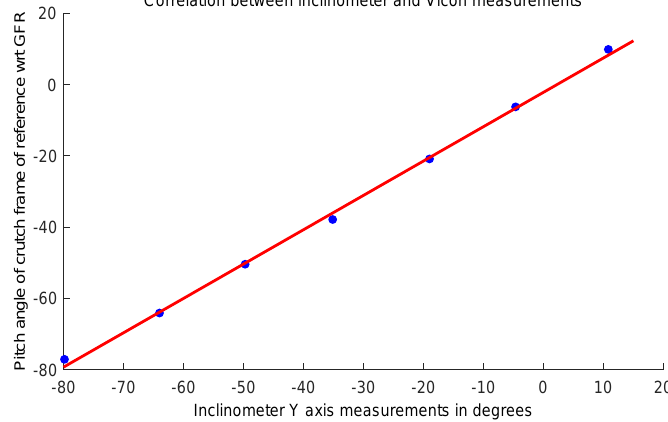
Figure 5. Best fitting straight line for the inclinometer